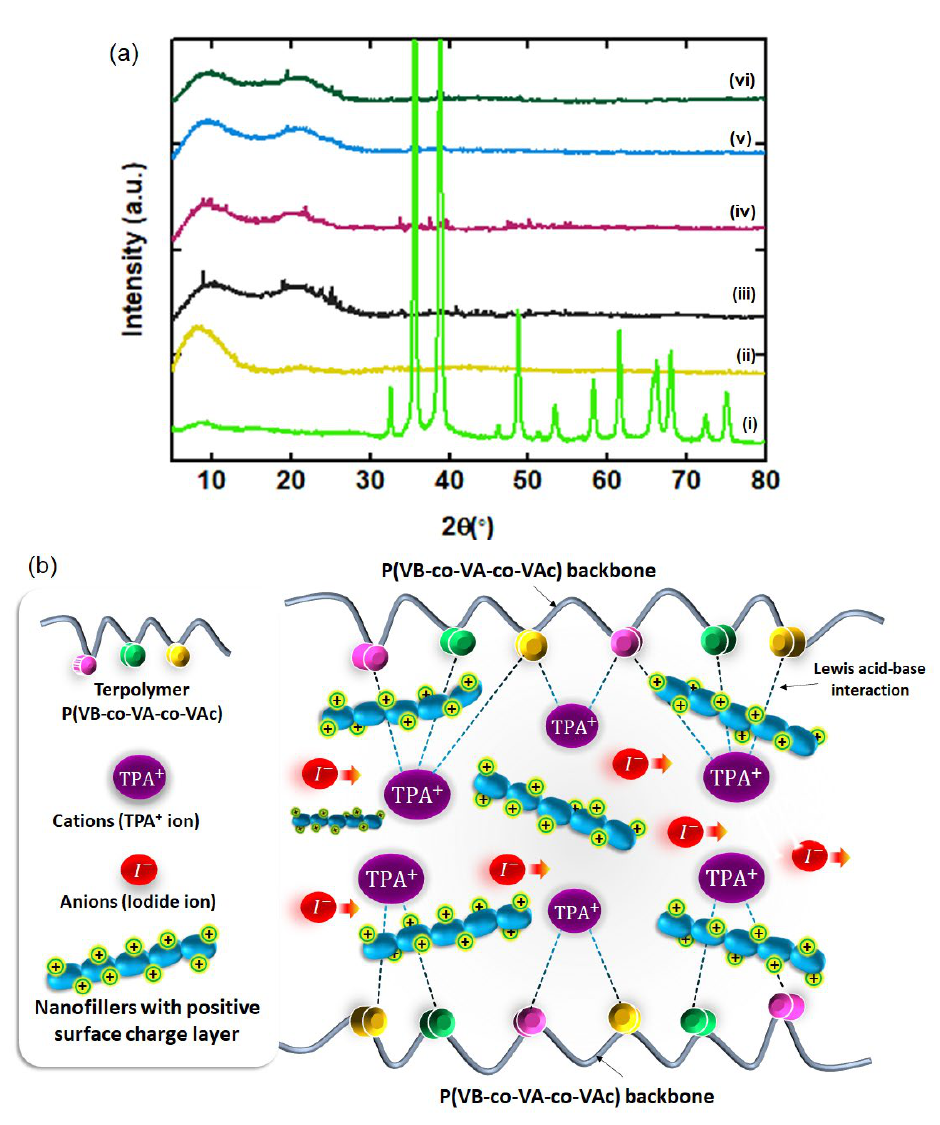
Figure 2. ( a ) XRD pattern for (i) CuO-350 nanofiller, (ii) TPAI-4, (iii) TCu(OH) 2 , (iv) TCuO-200, (v) TCuO-350, and (vi) TCuO-500; and ( b ) illustration of interaction between Lewis acid (TPAI salt and CuO nanofiller) and Lewis base (side chain of P(VB-co-VA-co-VAc) backbone). The reduction in the crystallinity of PCGE can be further confirmed by coherent TPAI-4 exhibits two peaks: sharp peak at 2 θ = 8.5 ◦ and broad peak at 2 θ = 21.9 ◦ ,